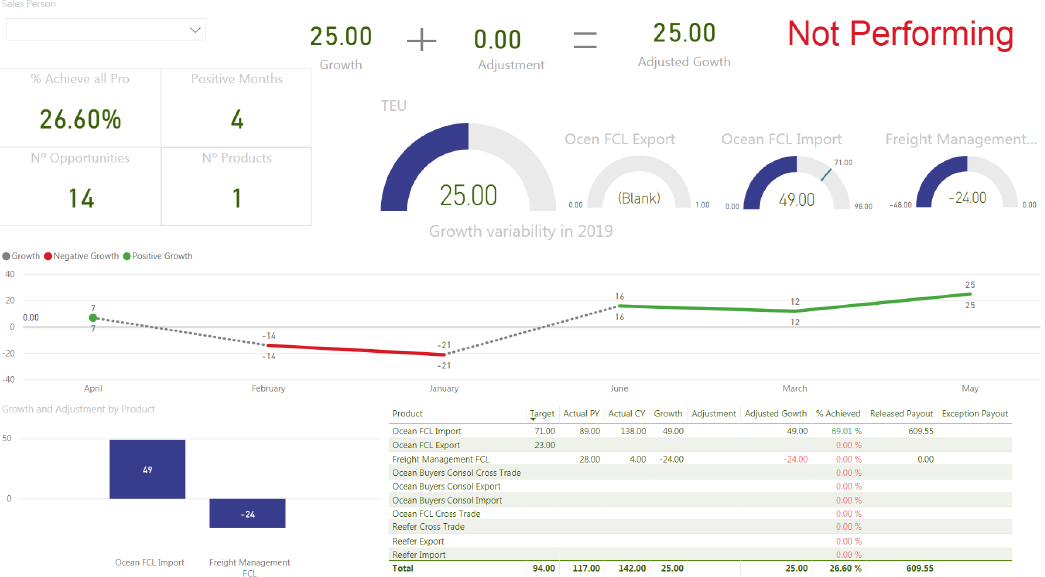
Figure 9. Dashboard for a salesperson classified as Not